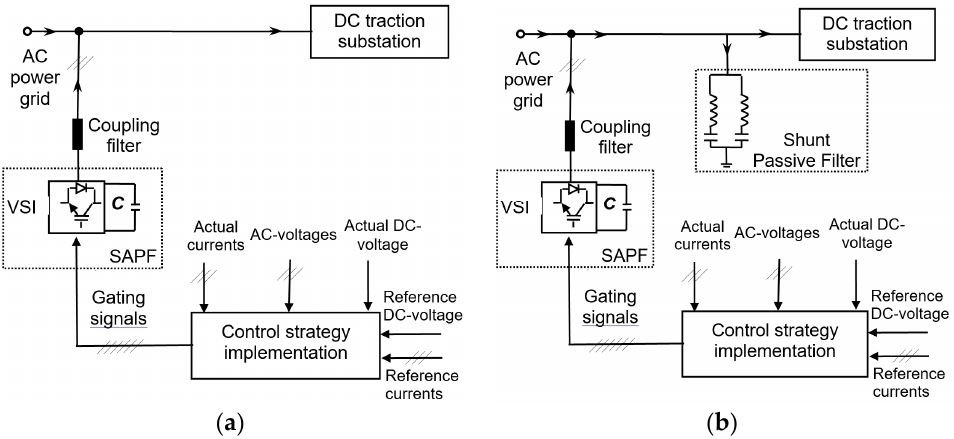
Figure 2. Structure of shunt active power filter (SAPF)-based compensator used in DC-traction substations: ( a ) simple SAPF and ( b ) hybrid compensator.